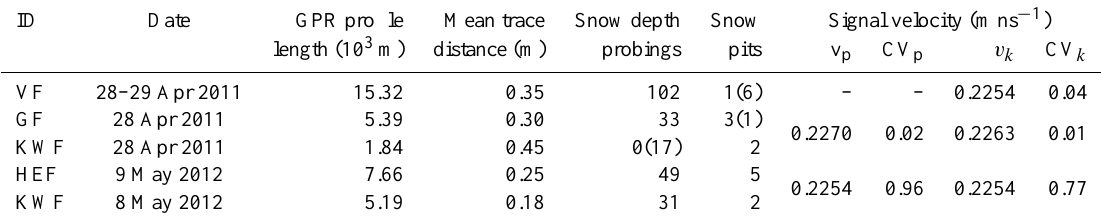
Table 1. Attributes of the field measurements in spring. Number of snow depth probings and snow pits shown in brackets indicate measure- ments not directly located at the GPR profiles. The GPR signal velocities derived from snow depths of the reflecting snow layer in the snow pits ( v p ) and GPR signal velocities calculated from measured snow densities ( v k ) using Eqs. (7) and (8) with the corresponding coefficient of variation (CV, Eq.